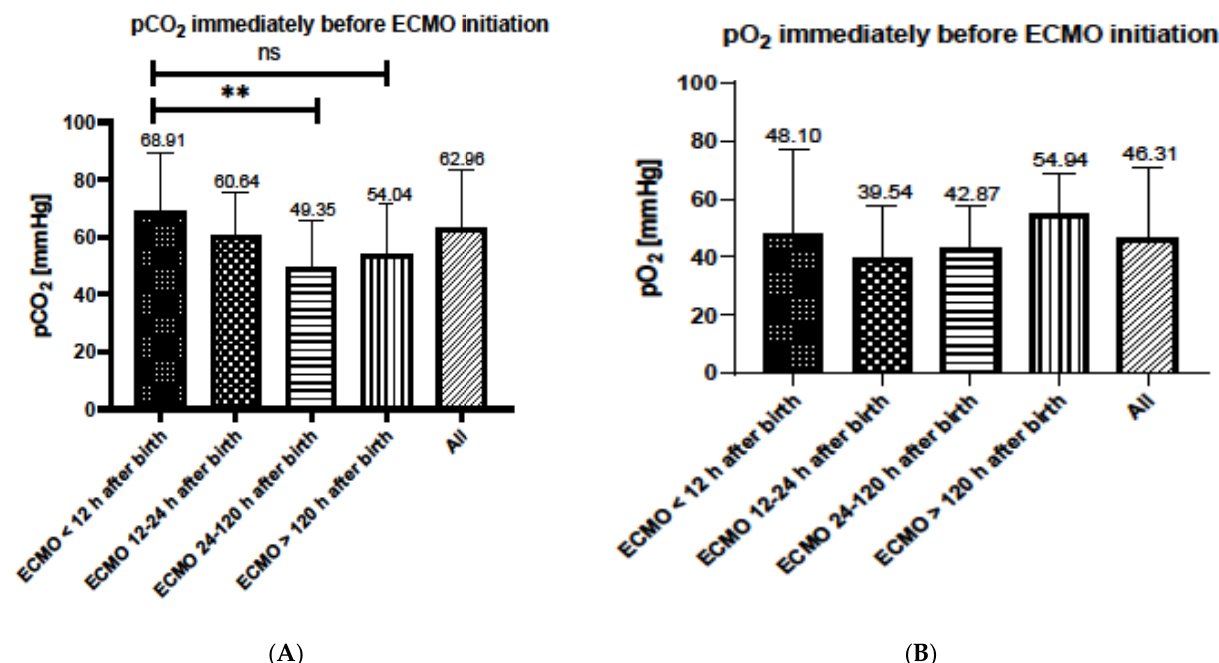
Figure 1. Ventilation ( A ) and oxygenation ( B ) parameters prior to ECMO initiation. ** statistically significant. “ns” stands for not significant.